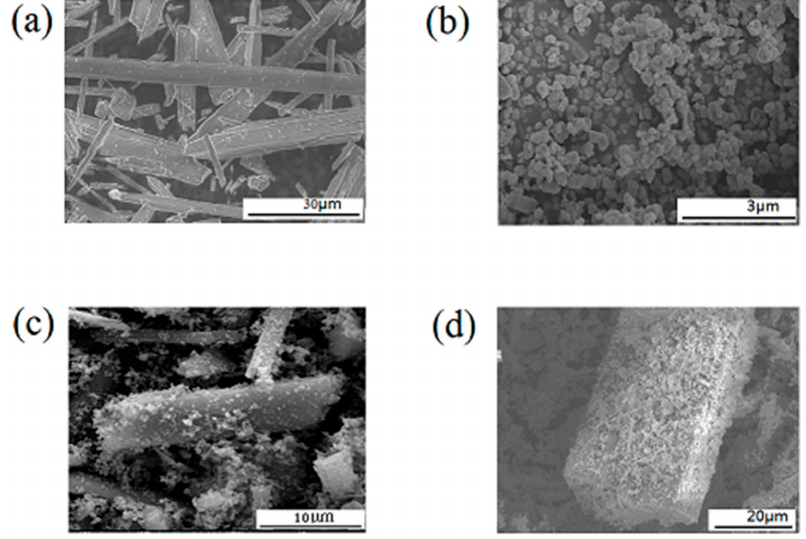
Figure 2. The scanning electron microscope (SEM) images of wollastonite, TiO 2 and TiO 2 -coated wollastonite composite pigments. ( a ) Wollastonite raw material; ( b ) anatase TiO2 raw material; ( c , d ) TiO 2 -coated wollastonite composite